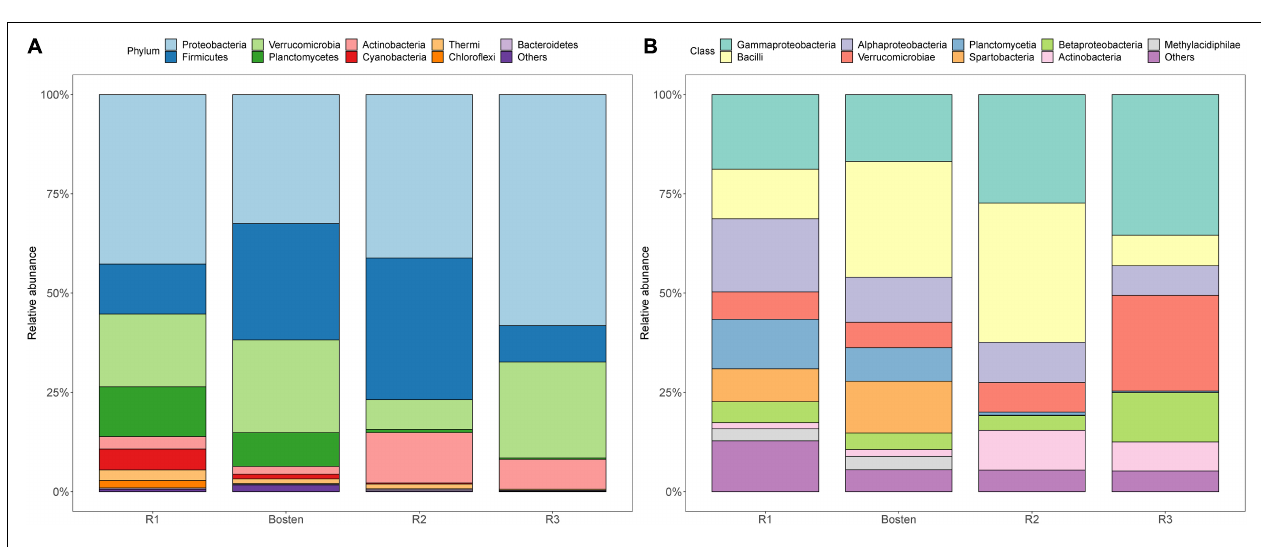
followed by Firmicutes (21.66%) and Verrucomicrobia (18.34%). Planctomycetes prevailed in both Lakes R1 and Bosten but was rare in Lakes R2 and R3 (10.53 vs. 0.57%); in contrast, Actinobacteria was less dominant in Lakes R1 and Bosten but